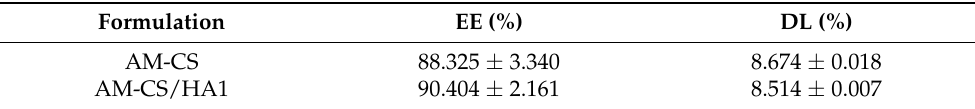
Figure 1. SEM photomicrographs of ( a ) AM-CS and ( b ) AM-CS/HA1. Table 3. The average of EE and DL of the nanoparticles.